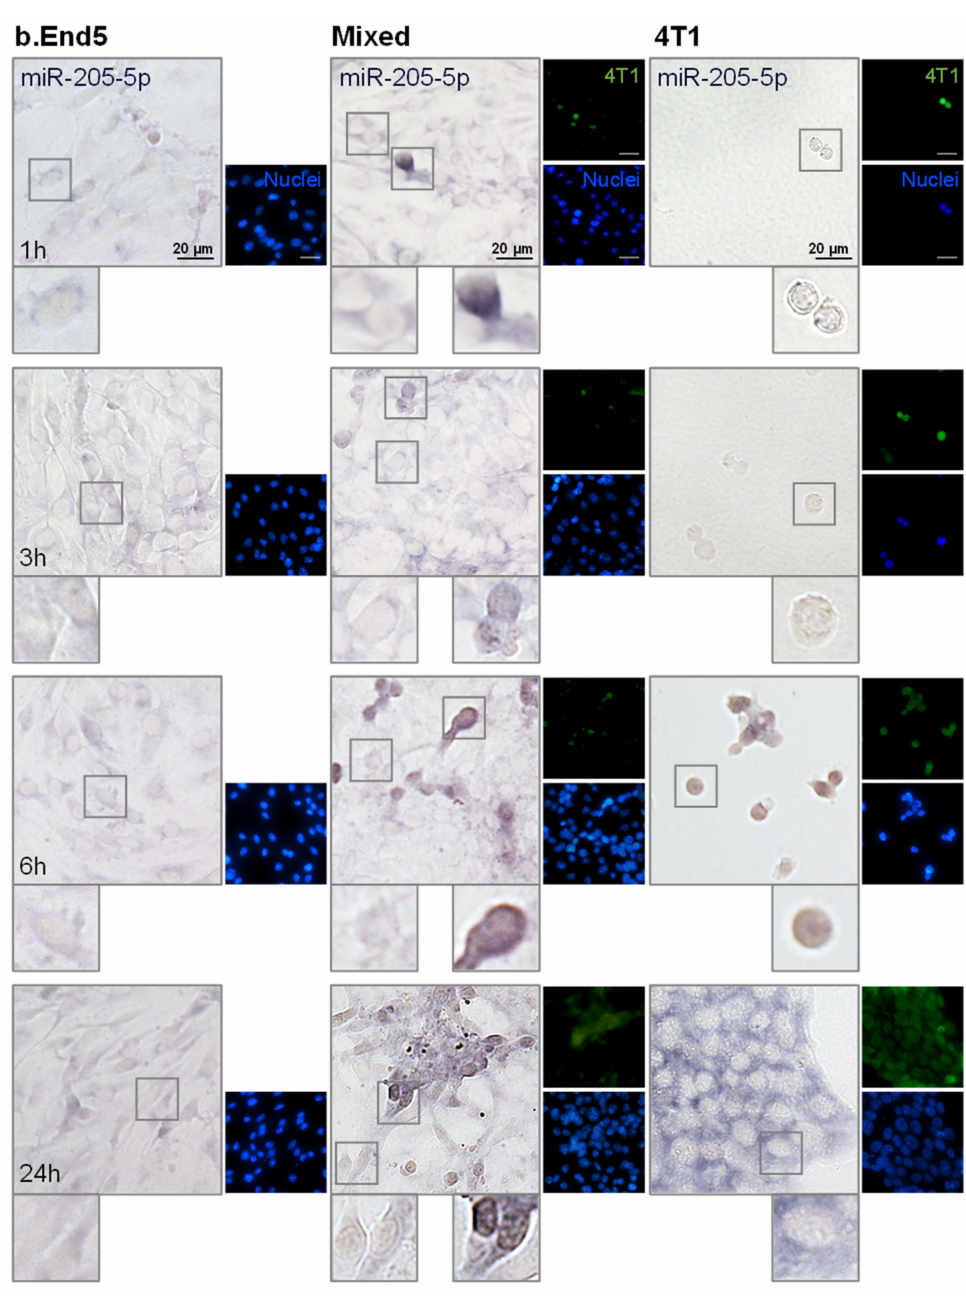
Figure 5. miR-205-5p is expressed by brain microvascular endothelial cells (BMECs), breast cancer cells (BCCs) and during BMEC–BCC interaction. Single cultures of 4T1 cells (BCCs), b.End5 cells (BMECs) and mixed cultures of b.End5 and 4T1 cells (previously labelled with CellTracker™ Green) were performed under physiological shear stress for 1, 3, 6 and 24 h, after which cells were fixed and processed for in situ hybridization (ISH) for miR-205-5p and nuclei (blue) were counterstained with Hoechst 33342. Insets highlight major cellular alterations of miRNA expression in both cell populations (BMECs: left; BCCs: right) along time. ISH for miR-205-5p revealed a bluish coloration mainly in large BCCs clusters at later time